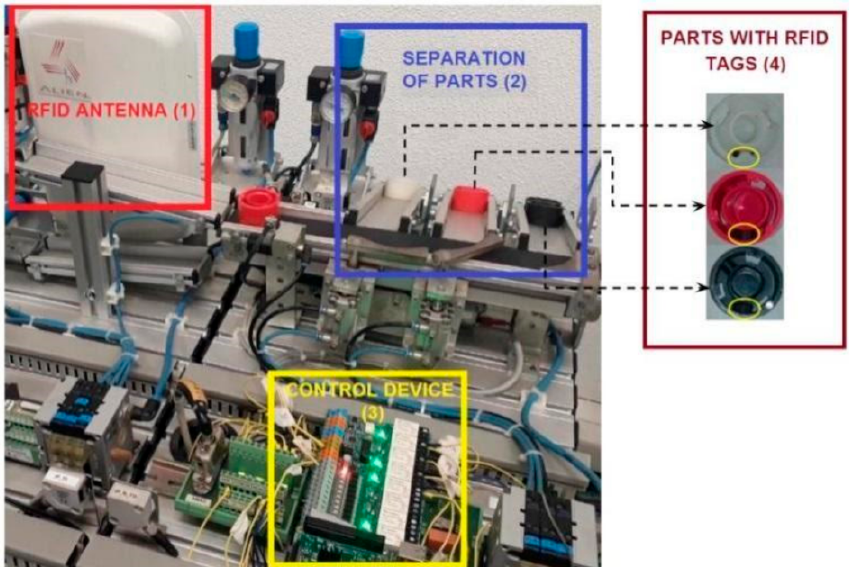
Figure 7. Details of the experiment: stations, parts and control